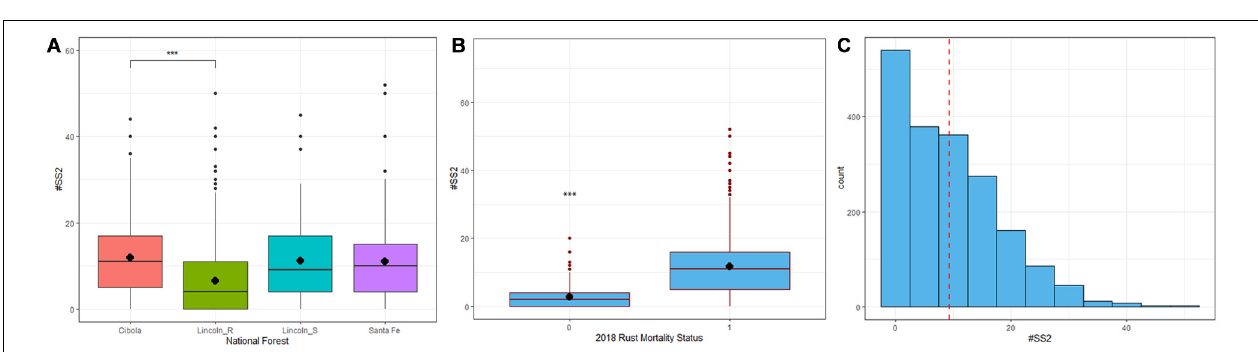
FIGURE 4 | For trees that remained alive (stem symptom free and 100% mortality families removed) with stem symptoms (SSALV 7 ) at the final assessment (7.42 years post-inoculation) the mean severity remained relatively low (1.48). (A) There was no significant difference at 95% confidence in the mean severity for SSALV 7 at the forest population scale. There was a range of severity suggesting that several trees may have quantitative resistance. (B) There were some significant differences between families ( ∗∗∗ P < 0.001, ∗∗ P < 0.01, and ∗ P < 0.05). Gray points reflect jittered individual seedling values for severity within forest stands (A) or families (B) .